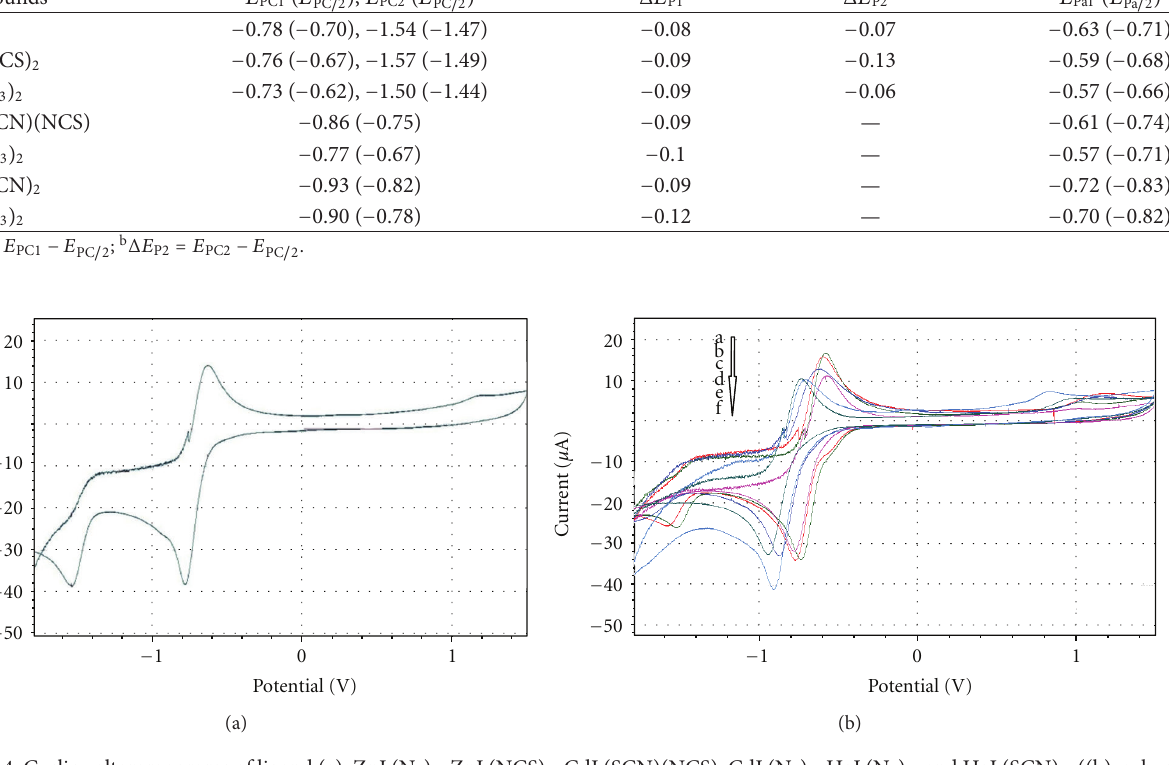
F 4: Cyclic voltammograms of ligand (a),